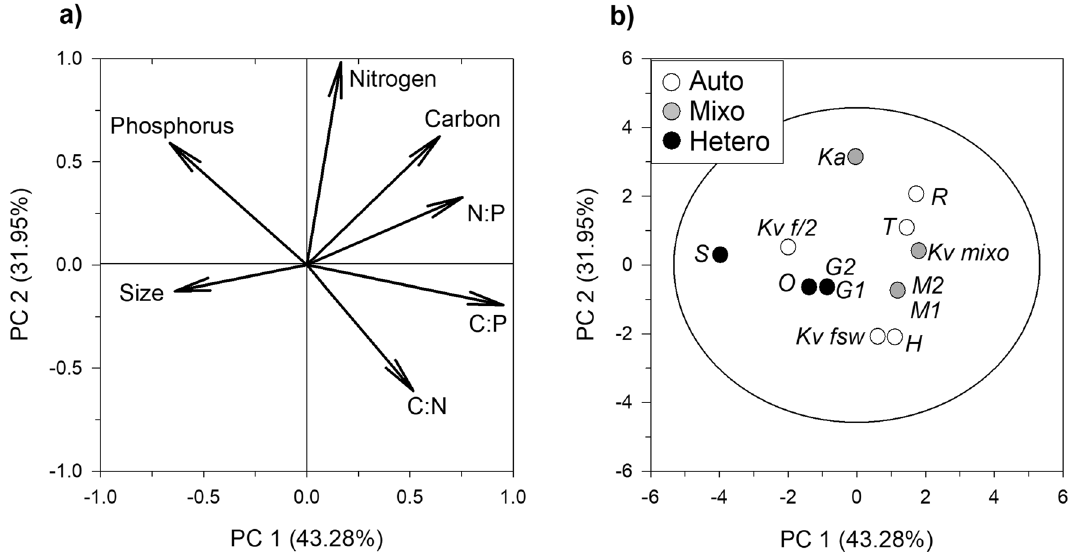
Figure 1. Principal component analysis. ( a ) Component loadings of the original variables and ( b ) component scores of combinations of the original variables along the two principal component axes. The circle in ( b ) depicts the Hotelling’s T 2 with 95% confidence interval. Abbreviations in ( b ) are described in Table 3.